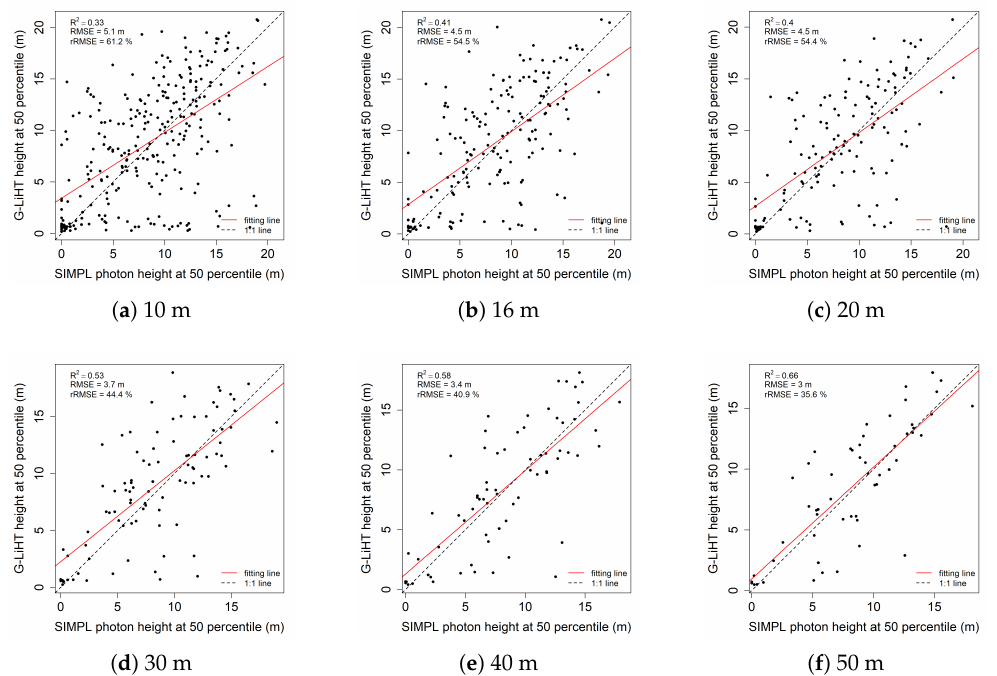
Figure 11. The relationship between the 50th percentile of all photon heights from SIMPL and the 50th percentile of all return heights from G-LiHT for different